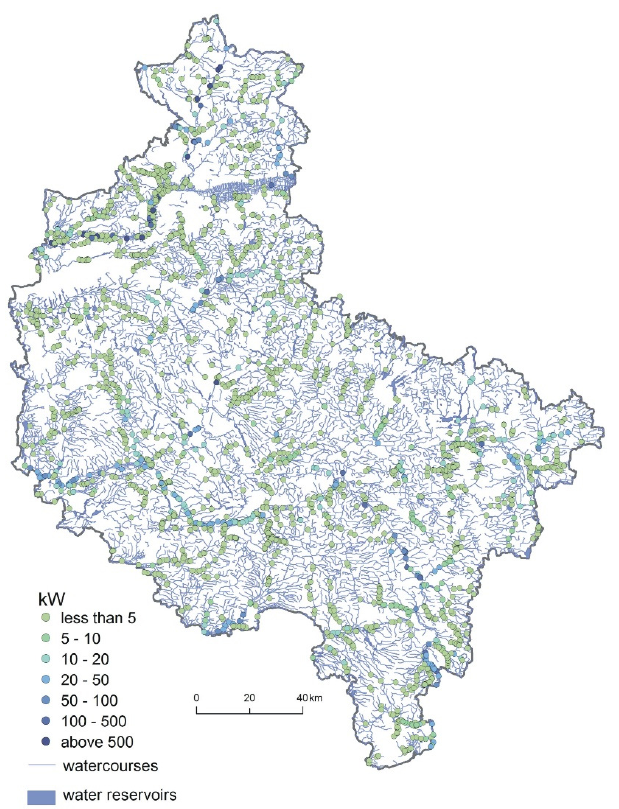
Figure 20. Localization of water dams and power of the potential hydropower plants in the Wielko- polskie voivodeship (own elaboration).